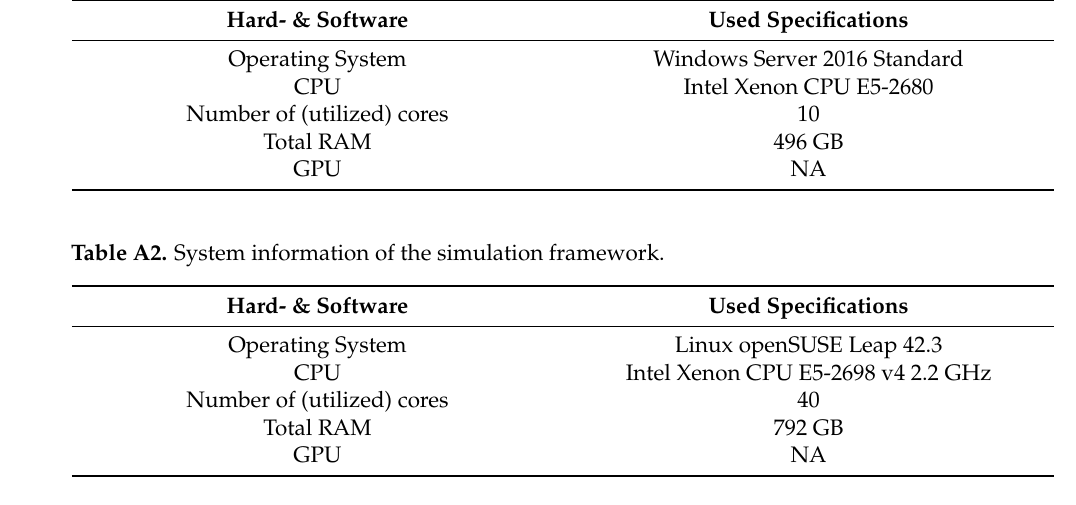
Table A1. System information for sampling and machine learning.